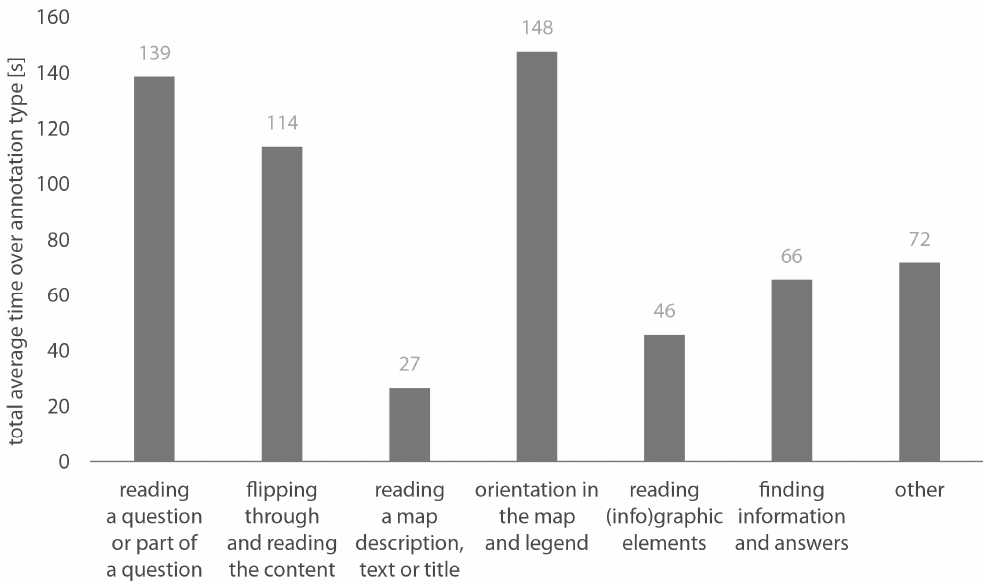
Figure 10. Average time of each annotation for all participants.